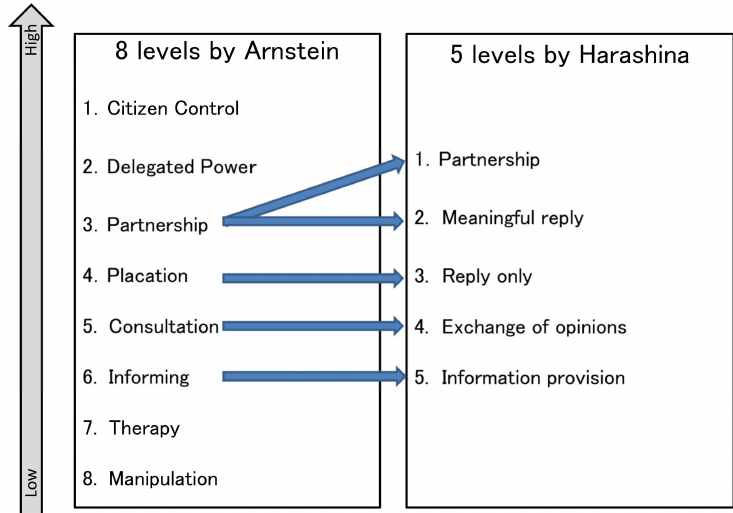
Figure 2. Eight and five levels of participation. Source: based on